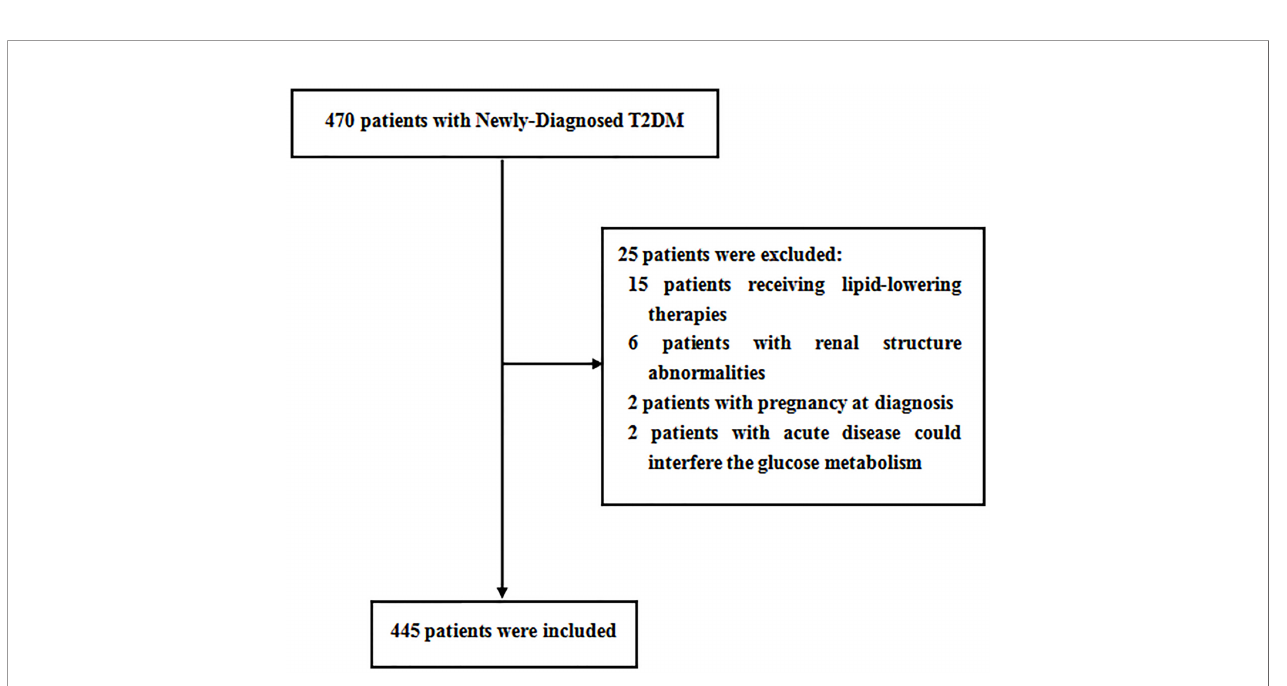
FIGURE 2 | Flow diagram of the patients excluded and included in this study.